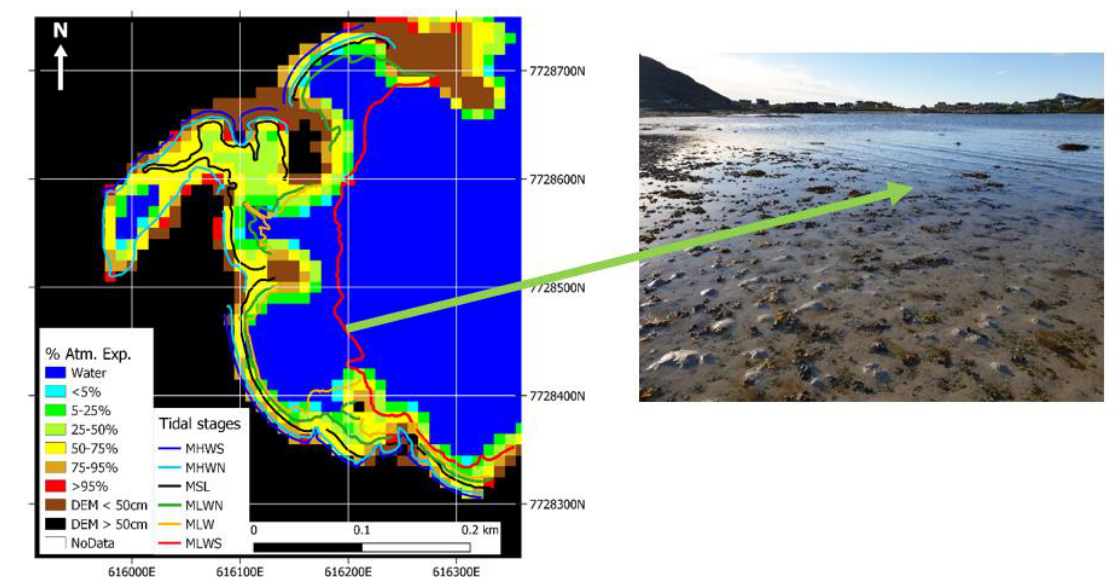
Figure 15. ( left ) GPS tracks of water lines at approximative reference tidal stages superimposed on the ITZ atmospheric exposure product in Avløsbukta at Hillesøy, Troms. The arrow indicates the position of the ground photo taken on 6 June 2020 of a water-saturated mudflat area, showing the difficulty in defining a clear water line in such areas. Remote Sens. 2021 , 13 , 3354 18 of 24 Table 5. Validation confusion matrix of the ITZ AtmExp. product versus GPS tracks along the different tidal reference levels. Note that the classes do not correspond to each other as the tidal level lines correspond to the border between classes. Gray cells indicate correct classification in regard to the individual tidal reference lines. User and producer accuracies are indicated. The red squares indicate the correct classification into low-, mid-, and high-tide regions. The last line indicates the accuracy to map a certain reference line as part of the ITZ area.